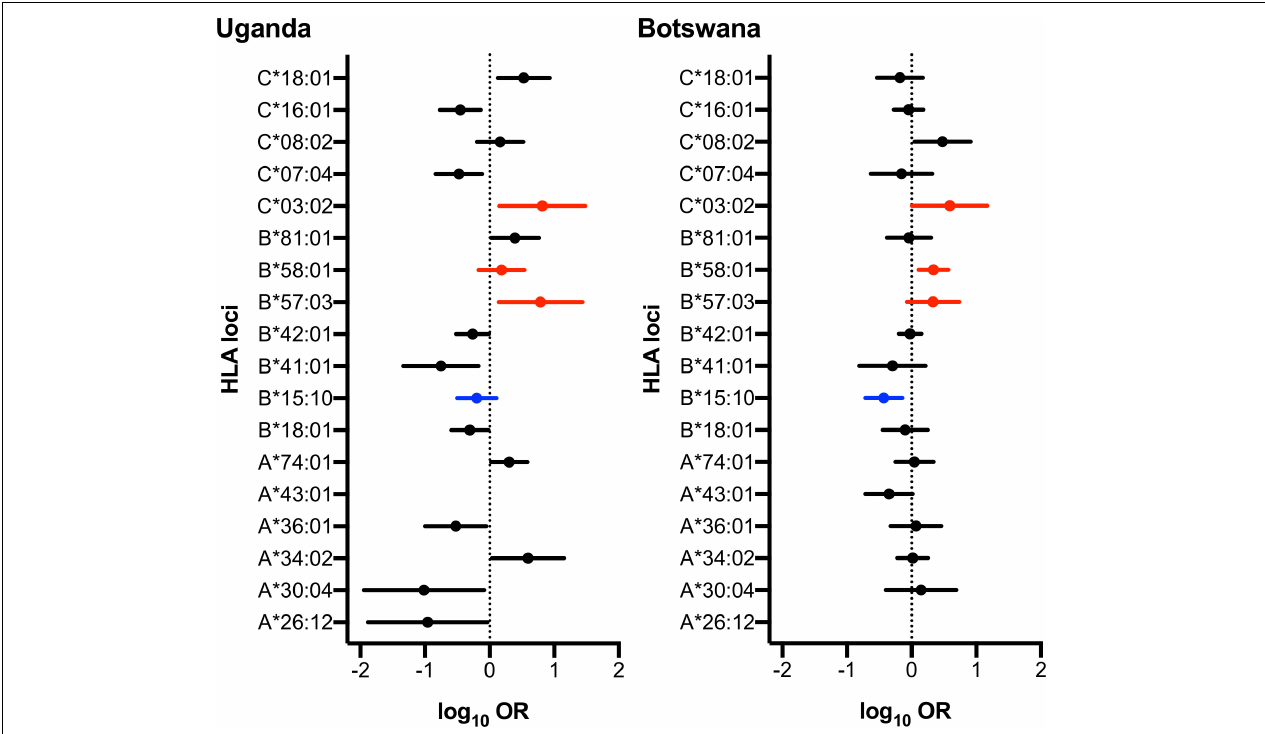
FIGURE 5 | Forest plot of HLA alleles associated with LTNP in Uganda and Botswana. Only alleles found to be statistically associated with HIV progression in either country are shown. Alleles highlighted in red and blue have protective and detrimental effects, respectively, in both populations. Log Odds Ratios (95% CI) are obtained from logistic regression adjusting the effect of gender on HIV disease progression in each